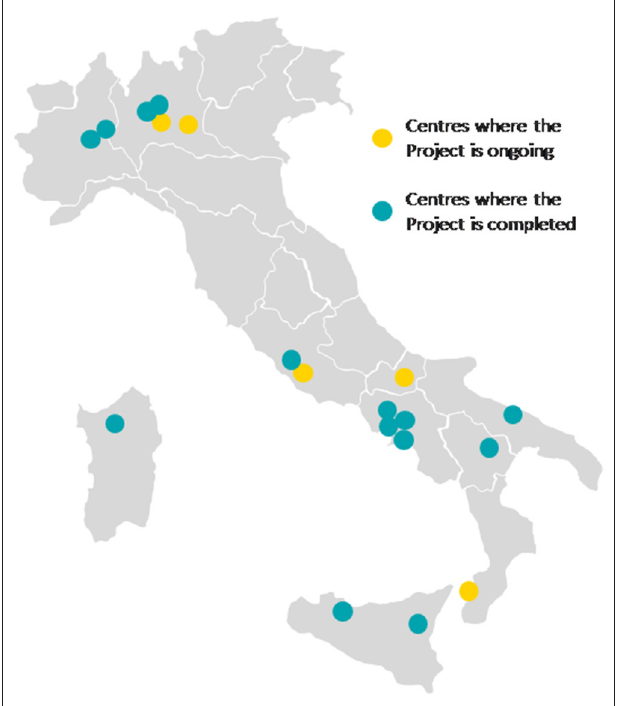
FIGURE 1 | Map of the centers involved in the “Early SpA Clinic”